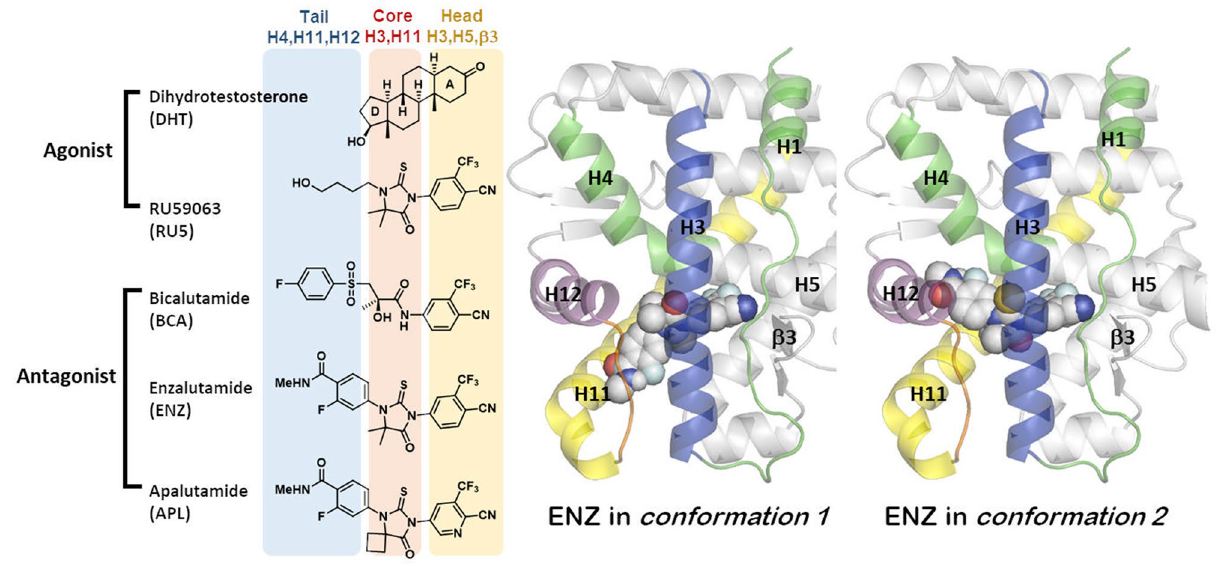
Figure 1. Representative AR agonists and antagonists. Two proposed binding conformations for enzalutamide in AR LBD. Images were created by using Chemdraw and VMD v1.9.3 52